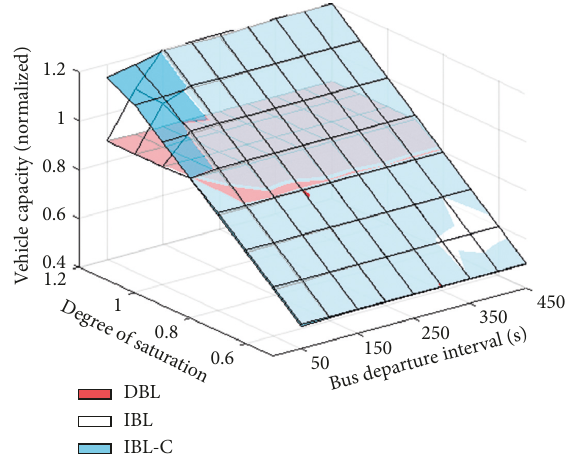
Figure 6: Traffic flow volume of road